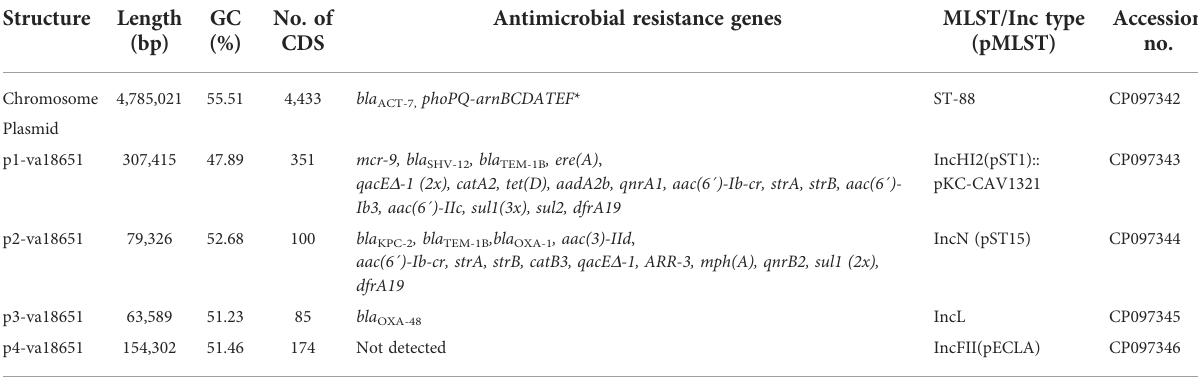
TABLE 2 Genomic features of Enterobacter xiangfangensis